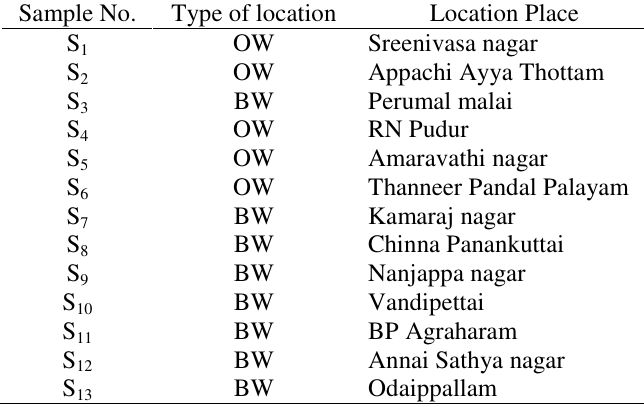
Table 1. Details of the sampling